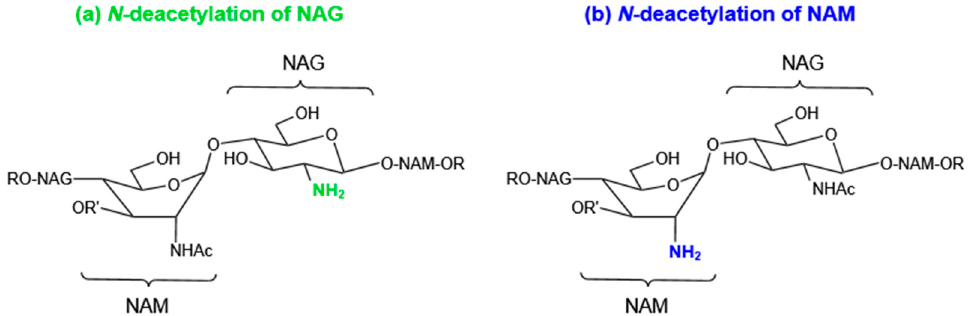
Figure 4. N -deacetylation of NAG ( a ) or NAM ( b ).